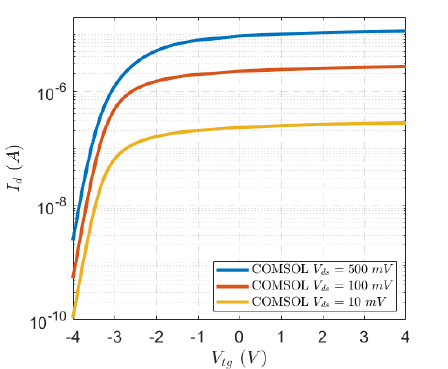
Figure 11. Transfer characteristic for different values of V ds